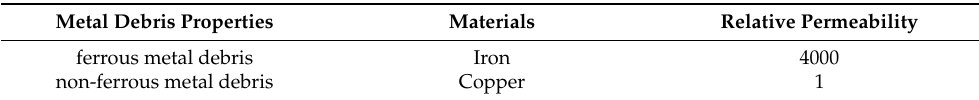
Table 2. Electromagnetic parameters of metal